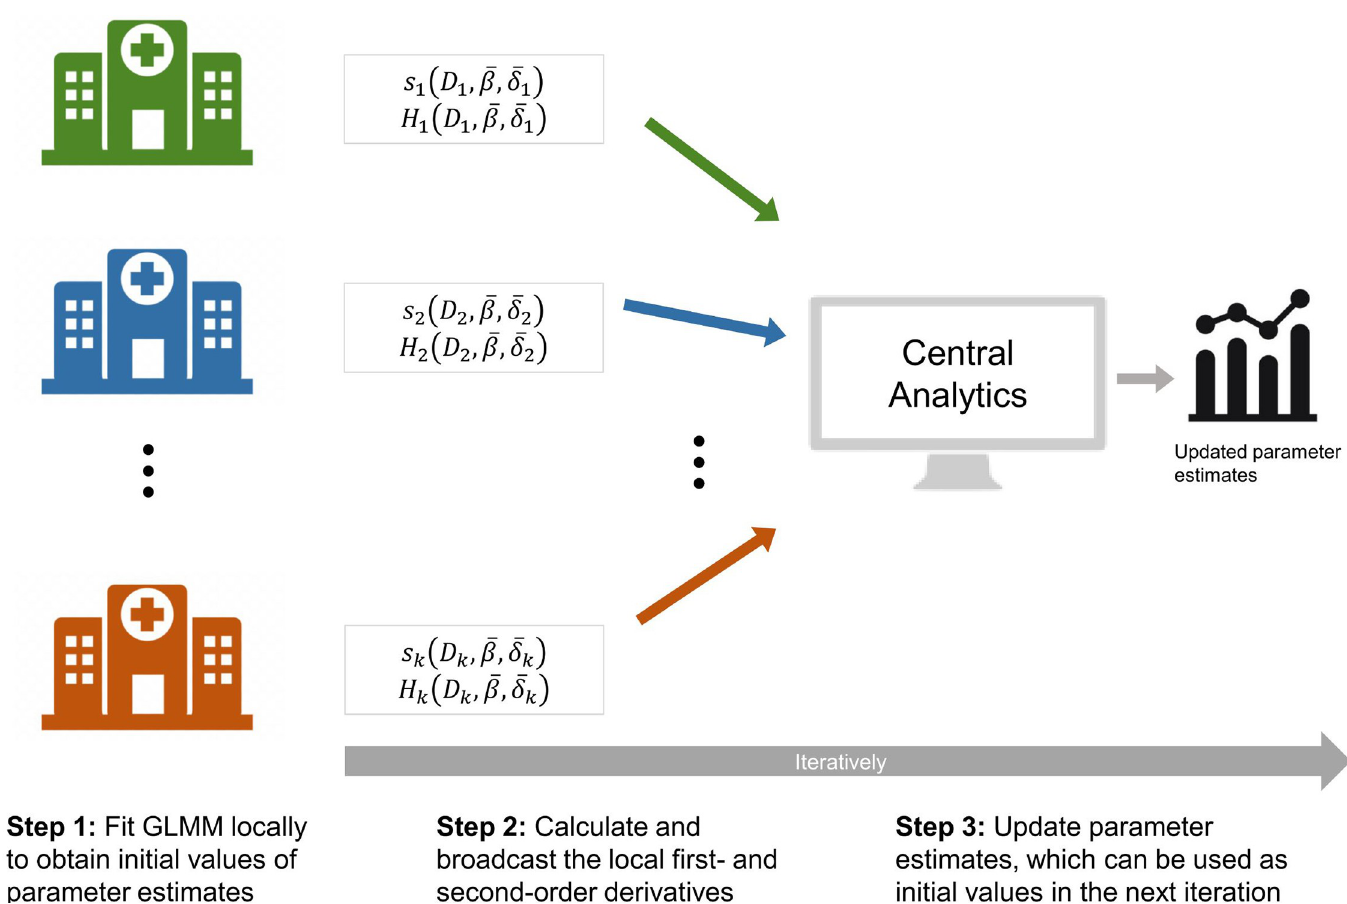
Fig 1. Schematic overview of Fed-GLMM. Fed-GLMM enables the joint implementation of GLMM for EHRs from multiple sites without sharing individual-level data. In step 1, each site fits GLMM locally to obtain the initial parameter estimates. In step 2, each site calculates intermediate summary statistics evaluated at the initial values and broadcasts them to the central analytics. For the k -th site, these summary statistics are denoted as s and H , and they are functions of the local data D , the common k k k parameter value � b � , and the site-specific parameter value � d � . The local data D is composed of the local design matrix for the common fixed effect X , the local design k k k , and the local outcome vector y . The site-specific parameter value � d � is composed of the values of site-specific fixed effect � a � and matrix for the site-specific fixed effect W k k k k site-specific variance parameter � g � . In step 3, the central analytics combines all the local intermediate results to construct a surrogate global likelihood function that k provides updates for parameter estimates. Steps 2–3 can be iteratively performed to keep updating parameter estimates.